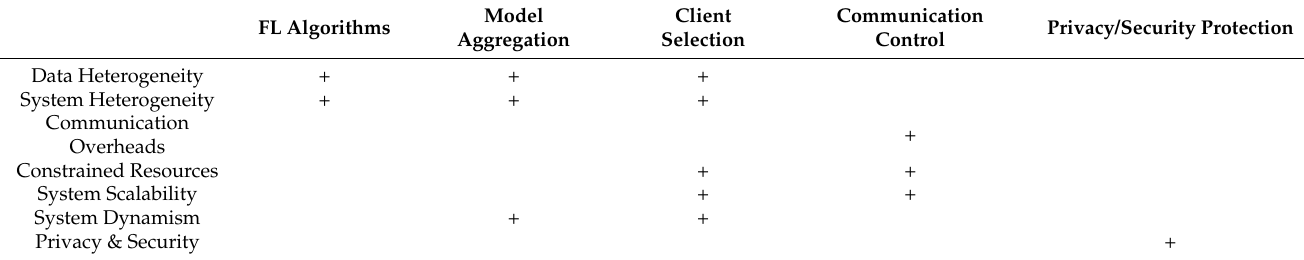
Table 2. The main challenges to FL in IoT and representative technical strategies for addressing them. FL